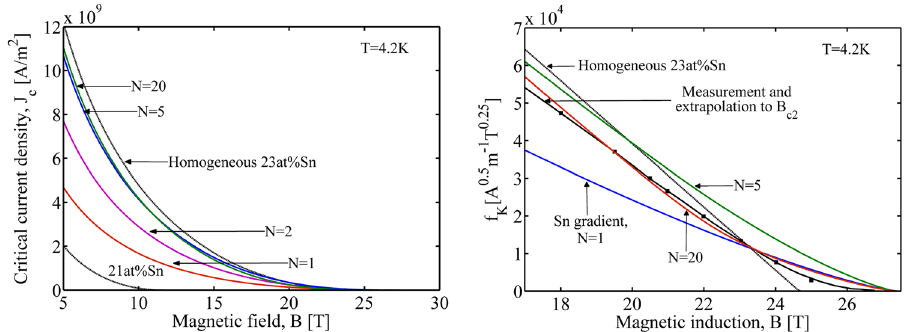
Figure 10. Effect of the composition gradient on the critical current density (Left) and Kramer function . . J B c0 5 0 25 (Right) of PIT wires. The measurements on SMI ternary PIT wire are duplicated from ref. 2. The Kramer plot with a composition gradient N = 20 has a positive curvature approaching the